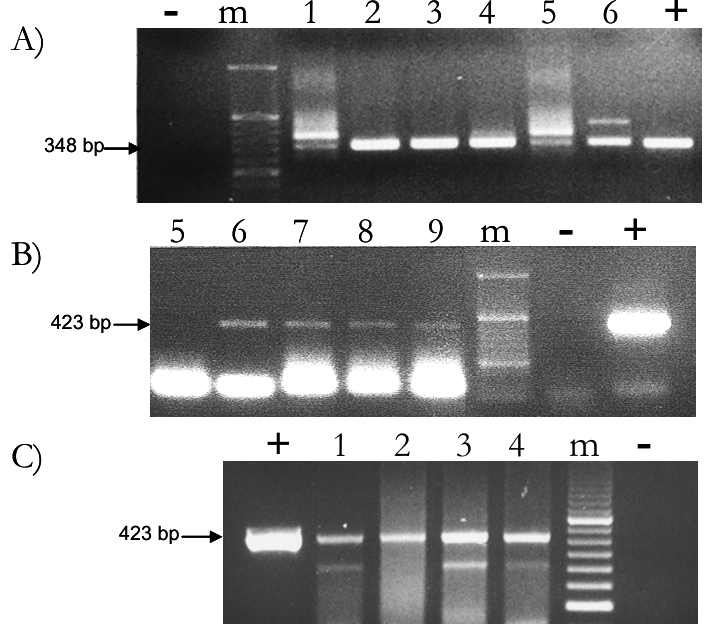
milk samples collected from stock farms (A-B) and in two different brand-labeled milk samples sold in the Italian market (C). (A) rbcL 348 bp long fragment amplified with the use of the Arub fw/rv set of primers from 400 ng of DNA isolated from the skimmed fraction of six different cow milk samples. (B) rbcL 423 bp long fragment amplified with the use of the Lrub fw/rv set of primers from 400 ng of DNA isolated from the skimmed fraction of five different cow milk samples. Milk samples number 5 and 6 are in common between the two panels. (C) rbcL 423 bp long fragment amplified with the use of the Lrub fw/rv set of primers from 2 brand labeled milk samples. Lane 1, 2: 400 ng and 800 ng of total DNA extracted from n° 1 brand-labeled sample; lane 3, 4: 400 ng and 800 ng of total DNA extracted from n° 2 brand-labeled sample; m: molecular marker; “+”: plant DNA positive control. “-”: negative PCR control (just buffer, no